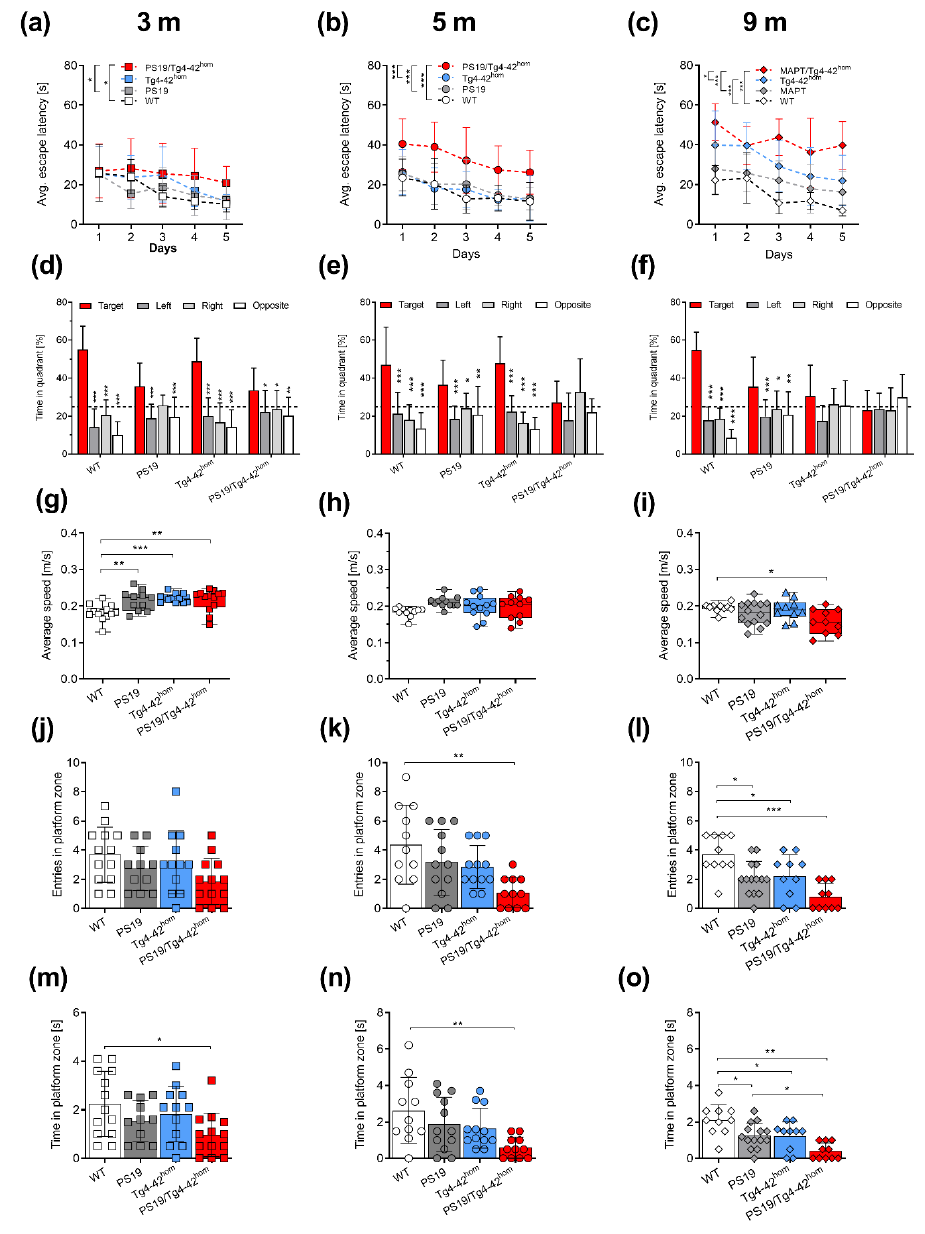
Figure 3. Spatial memory deficits in PS19/Tg4–42 hom mice. Female and male WT, PS19, Tg4–42 hom and PS19/Tg4–42 hom mice were tested in the Morris Water Maze test ( n = 10–12) at 3 ( a , d , g , j , m ), 5 ( b , e , h , k , n ) and 9 ( c , f , i , l , o ) months of age. Spatial learning deficits were detected during the acquisition training in PS19/Tg4–42 hom already at 3 months ( a ), which worsened with aging ( b , c ). No spatial reference memory deficits were observed in young animals during the probe trial ( d ), while 5-month-old mice co-expressing A β 4-42 and mutant human tau failed to remember the position of the goal quadrant ( e ). Aged Tg4–42 hom and PS19/Tg4–42 hom mice both displayed deficits in the probe trial ( f ). The transgenic lines swam significantly faster than WT littermates at young age ( g ), while no differences in average speed were observed at 5 months of age ( j ). Aged PS19/Tg4–42 hom swam significantly slower than WT controls ( i ). Compared to WT mice, PS19/Tg4–42 hom mice showed a reduced time in the platform zone at 3 ( m ) and 5 months ( l ), as well as a reduced number of platform zone entries at 5 ( k ) but not at 3 months of age ( j ). All three transgenic lines showed reduced entries and time spent in platform zone at 9 months ( l , o ). All data are expressed as mean ± SD. ( a – c ) Two-way RM ANOVA or ( d – f ) Two-way ANOVA followed by Bonferroni’s multiple comparison test. ( g – o ) One-way ANOVA followed by Bonferroni’s multiple comparison: * p < 0.05, ** p < 0.01, *** p <